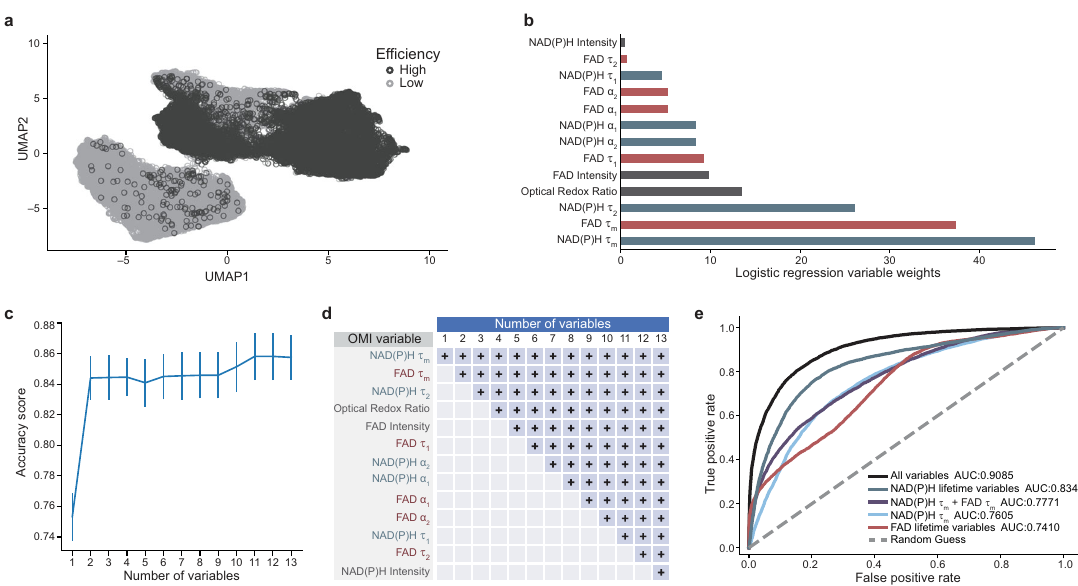
Fig. 3 OMI variables accurately distinguish cells under low or high cardiomyocyte differentiation ef fi ciency conditions on day 1. a UMAP dimensionality reduction was performed on all 13 OMI variables (optical redox ratio, NAD(P)H τ m , τ 1 , τ 2 , α 1 , α 2 , and intensity; FAD τ m , τ 1 , τ 2 , α 1 , α 2 , and intensity) for each cell on day 1 and projected onto 2D space. Day 1 cells from all 15 conditions shown in Table 1 are plotted together with cells from low (< 50% cTnT + on day 12) and high ( ≥ 50% cTnT + on day 12) CM differentiation ef fi ciencies in light gray and dark gray, respectively. n = 16048 and 14415 cells for low and high differentiation ef fi ciency conditions, respectively. b – e All OMI data from day 1 cells were separated into two datasets. Dataset 1 was randomly partitioned into 80% portions for training and 20% portions for testing, respectively ( n = 8974 cells for training, n = 2244 cells for test). Dataset 2 was used for evaluation of classi fi er performance. Binary classi fi cation was tested for low (< 50% cTnT + ) vs. high ( ≥ 50% cTnT + ) differentiation ef fi ciency conditions on day 1. b OMI variable weights are shown speci fi c to the logistic regression model. c Classi fi cation accuracy with respect to number of OMI variables was evaluated by chi-squared variable selection to separate low and high differentiation ef fi ciency conditions with the logistic regression model. The number of variables included in the logistic regression model are indicated at bottom-axis. The accuracy scores are presented as mean ± STDEV. d The variables included for each logistic regression model [speci fi ed by numbers of variables on the x -axis in ( c )] are de fi ned, where the blue text indicates NAD(P)H lifetime variables and the red text indicates FAD lifetime variables. The OMI variables included in each instance (e.g., 3, 4) are indicated by a light blue + in each column. e Model performance of the logistic regression classi fi er was evaluated by receiver operating characteristic (ROC) curves using different OMI variable combinations as labeled. The area under the curve (AUC) is provided for each variable combination as indicated in the legend. Source data are provided as a source data fi